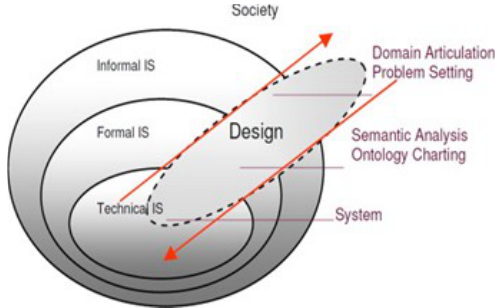
Fig. 8. SAC perspective about the design process in a social context. Extracted from